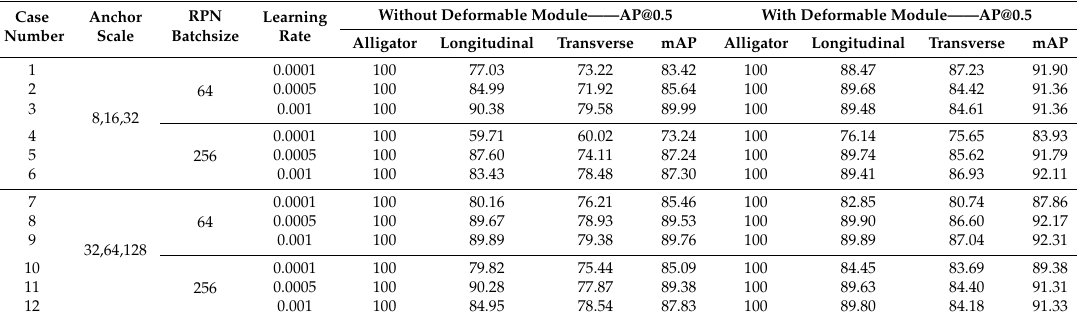
Table 3. Testing Results of FPN-based Faster